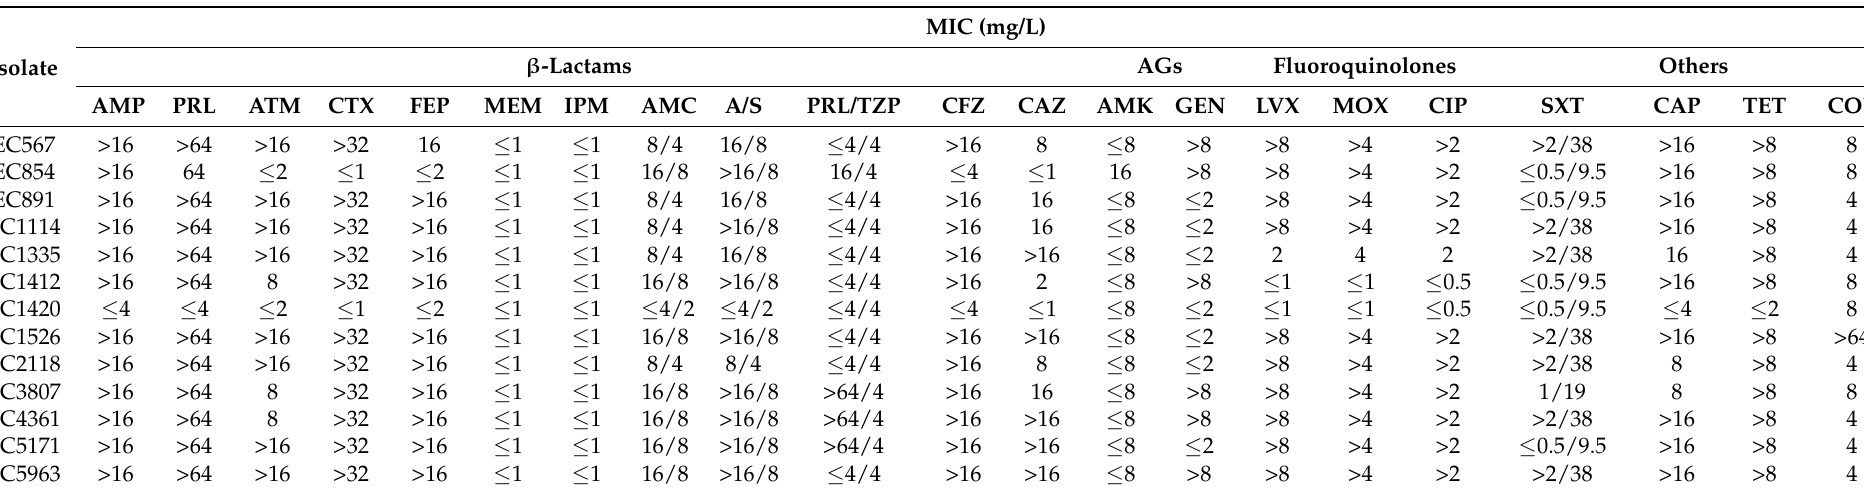
Table 2. Minimal inhibitory concentrations (MICs, mg/L) of the 13 mcr -carrying E. coli isolates to different antimicrobials.